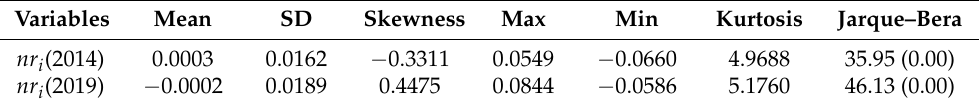
Table 1. Summary statistics.